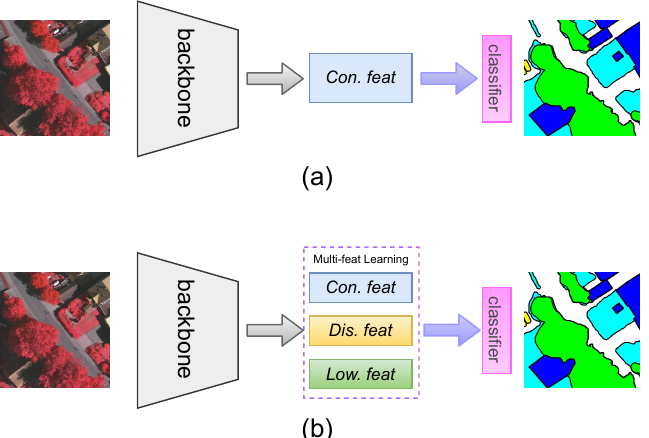
Figure 1. Comparative architecture in semantic segmentation. ( a ) Models based on captured con . feat. ( b ) The proposed multi-feature learning